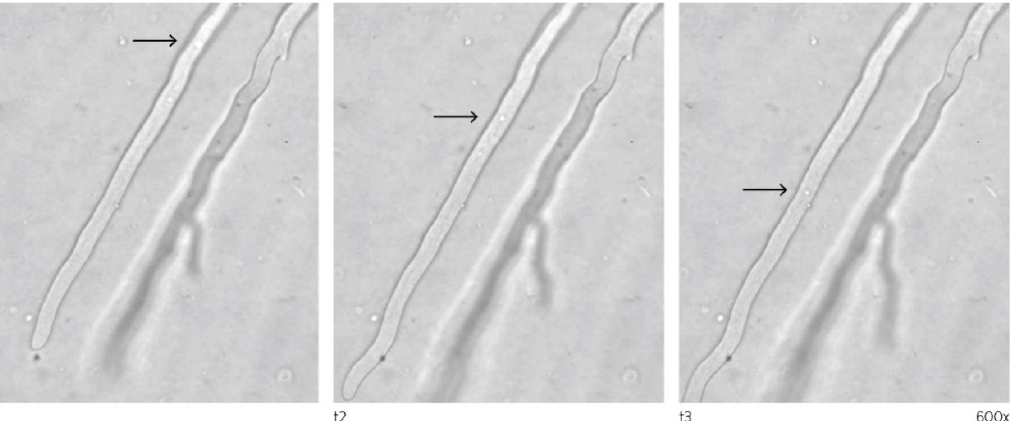
Figure 2. Microscopic imaging of growing hyphae with arrouw showing transport of particles. Photo by author.